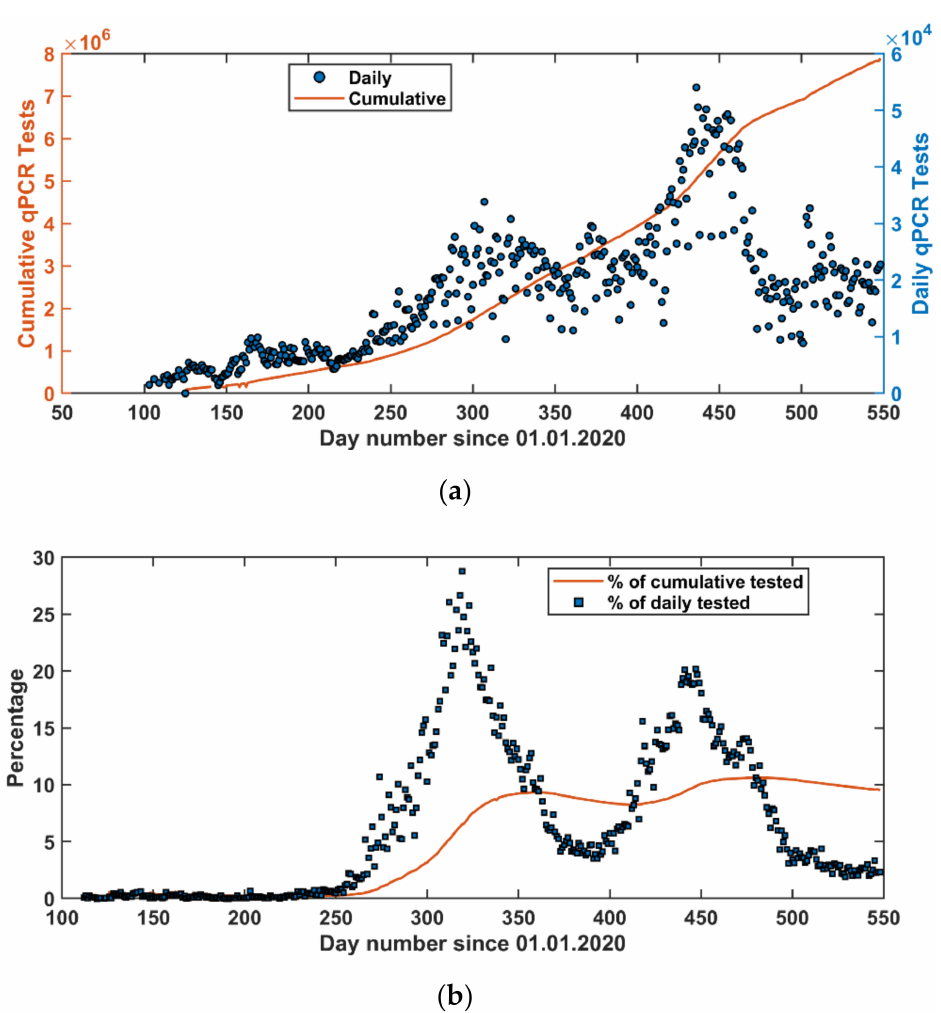
Figure 3. ( a ) Number of daily and cumulative qPCR tests performed in Jordan since the first case was reported (14 March 2020). ( b ) Daily and cumulative percentage of the positive qPCR cases out of the performed tests.